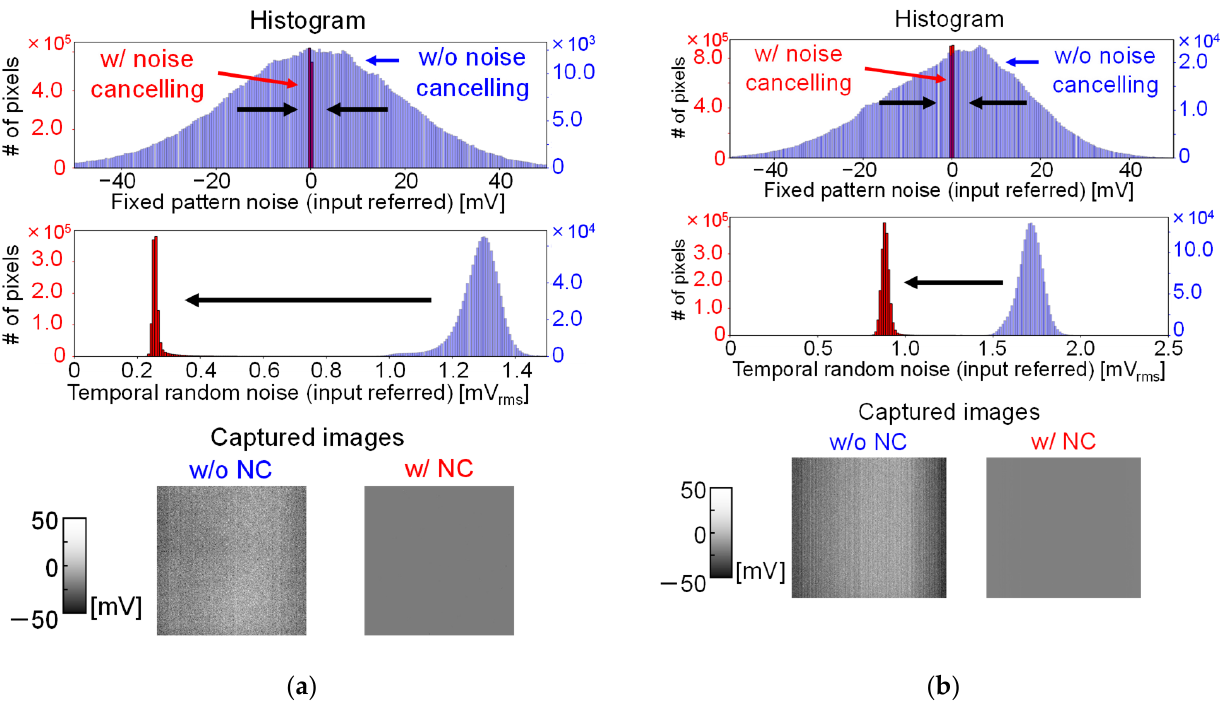
Figure 9. Captured images without and with noise cancelling and their histograms in the absence of targets: ( a ) Chip A; ( b ) Chip B. Table 1. Measured noise value of the two